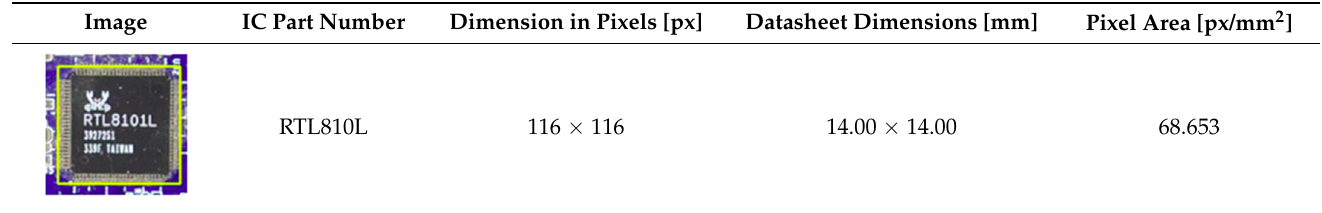
Table 2. Pixel area estimate.